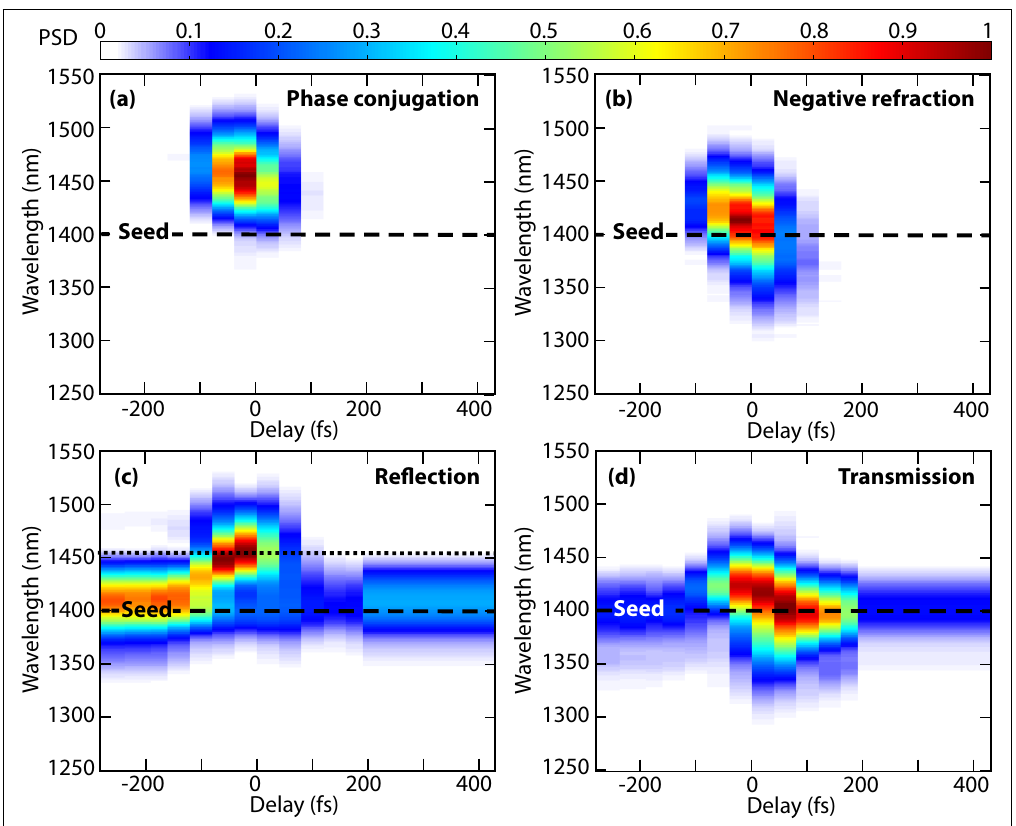
Figure 2. Measured spectrograms (normalised power spectral density (PSD)) for ( a ) the PC, ( b ) the NR, ( c ) the reflection, and ( d ) the transmission of the input seed field. See the colour bar for the PSD above panels ( a , b ). The horizontal axis in each panel denotes the delay between the pump and the seed pulses. The vertical axis indicates the wavelength. The dashed line is at the seed carrier wavelength (1400 nm), while the dotted line refers to the amplified seed measurement (see text for